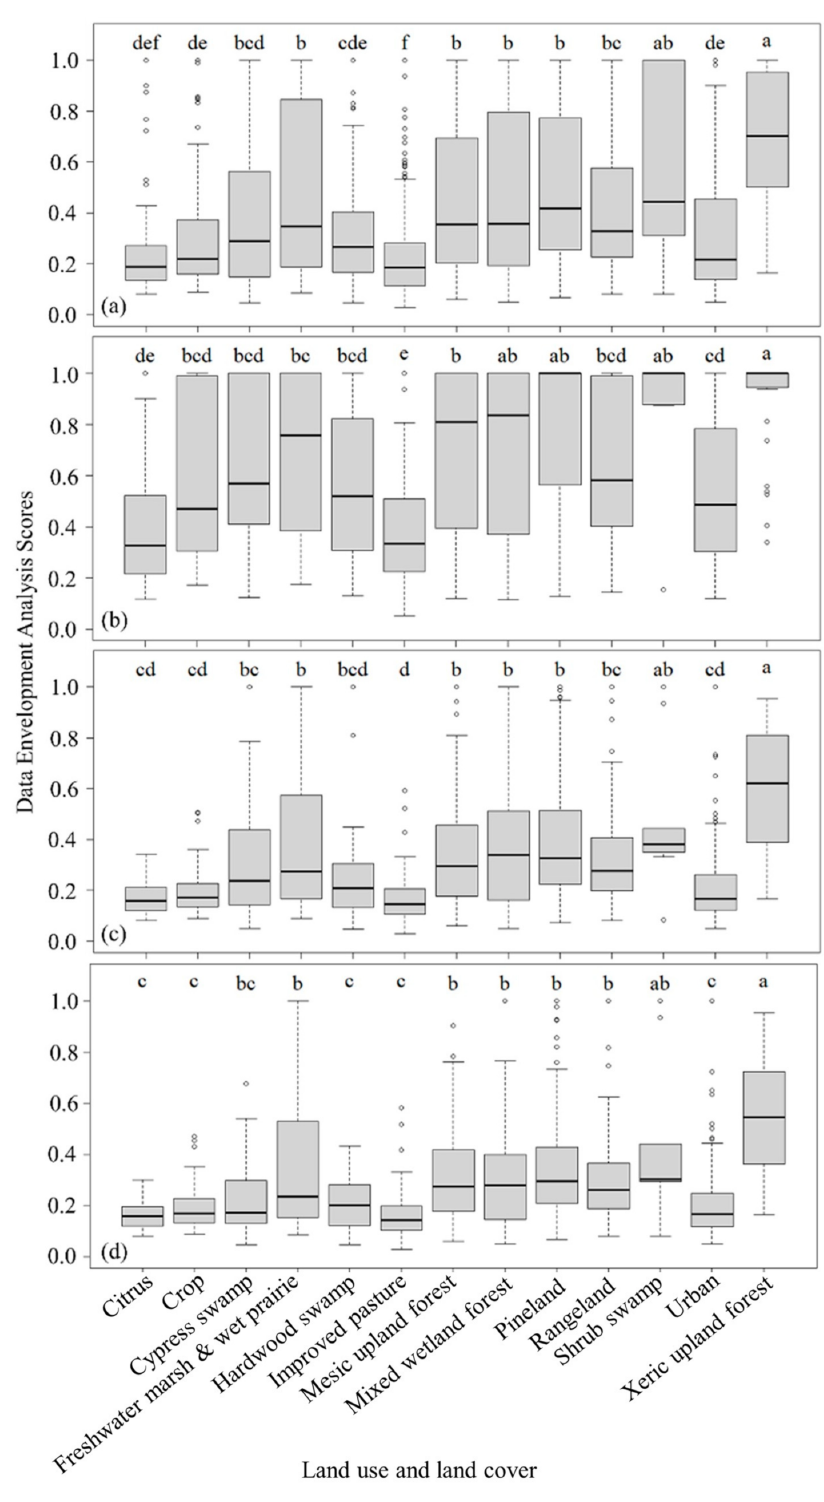
Figure 2. Data Envelopment Analysis scores by land use/land cover type. Letters in parenthesis in the lower left corners of the figure show the scores ( a ) altogether with three types of returns-to- scale (RTS); ( b ) free-disposable hull, ( c ) variable RTS, and ( d ) constant RTS. Note that letters denote significant differences in means between the variables based on the analysis of variance test with Tukey’s distance approximation ( p <